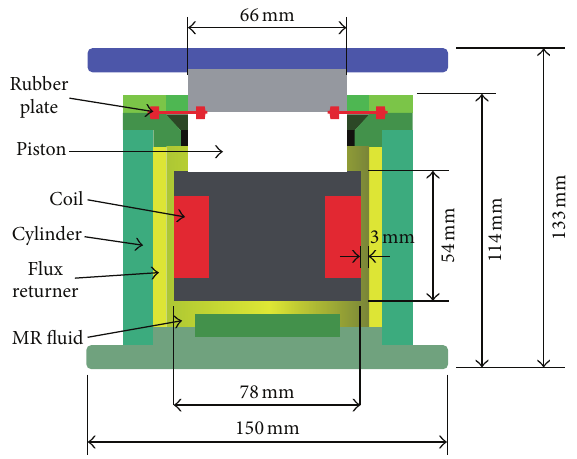
Figure 10: Detail configuration of integrated isolation